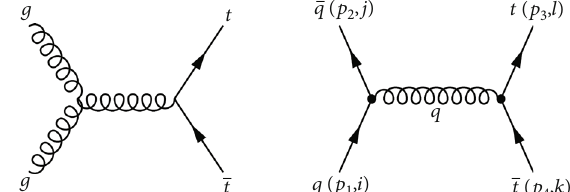
Figure 1: Tree level Feynman diagrams subprocesses for the Top quark pair